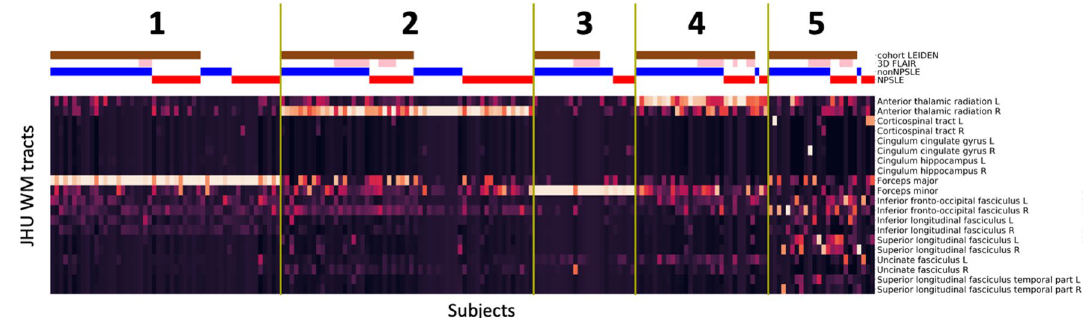
Figure 2. Cluster analysis on the entire SLE cohort. Heatmaps showing the 5 different MRI subtypes after the hierarchical clustering with the L2-normalization was performed. Subjects are shown on the x-axis and the Johns Hopkins University (JHU) white matter probability atlas tracts on the y-axis. The horizontal bars at the top show additional information: Leiden cohort (brown) complemented by the Lund cohort, 3D-FLAIR (pink) complemented by 2D-FLAIR, non-NPSLE (blue), NPSLE (red). FLAIR, Fluid-attenuated inversion recovery; NPSLE, Neuropsychiatric systemic lupus